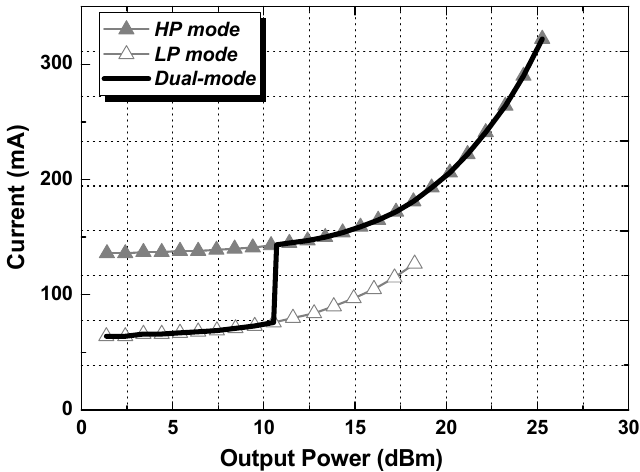
Figure 16. Measured current consumption for the 64-QAM OFDM signal with a bandwidth of 10 MHz at 0.91 GHz.